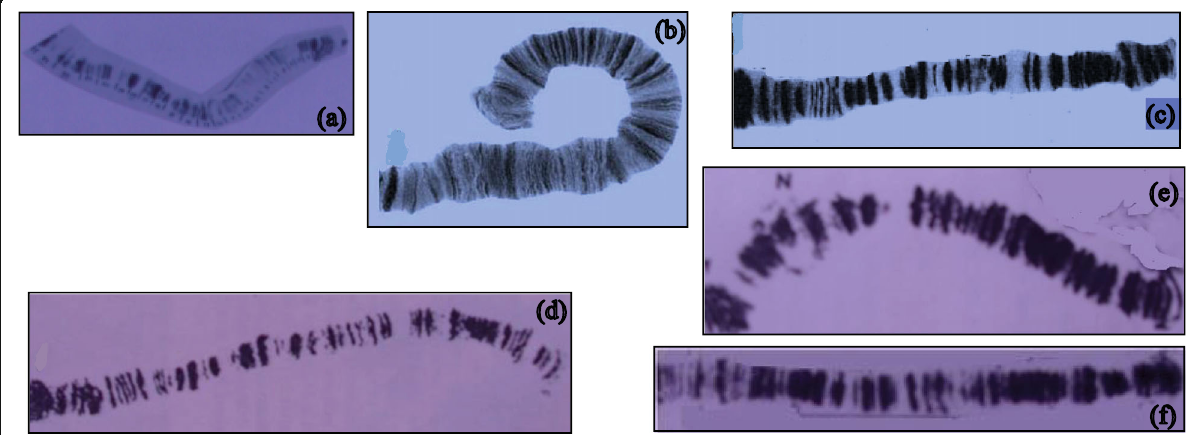
Fig. 7 Arm F of the polytene chromosomes of six species of Chironomus. a C. javanus. b C. dorsalis. c C. riparius. d C. mature. e C. maddeni. f C.